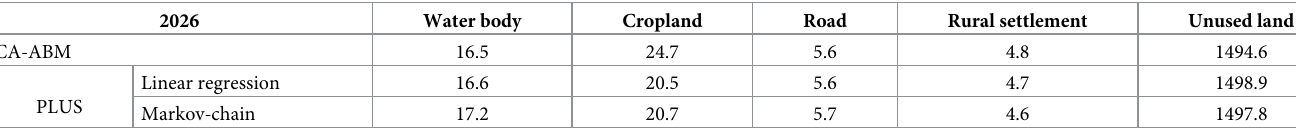
Table 6. Simulation results of land use in 2026 obtained with three methods (km 2